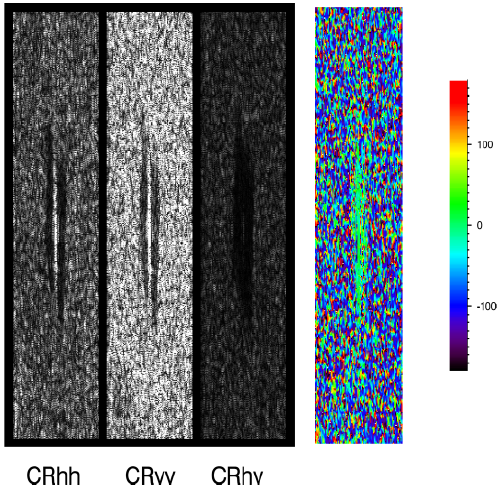
Figure 8. SLC amplitude images (HH,VV and HV polarizations) and phase image of the co-polar correlation coefficient for the calibrated SARAT data acquired along track 19 and relevant to the